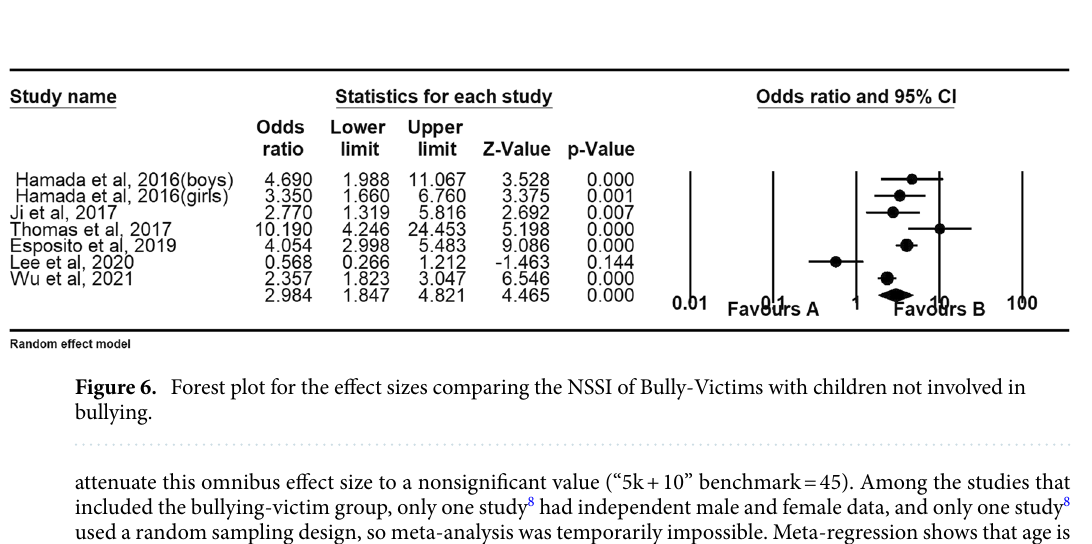
Figure 5. Filled funnel plot of the relationship between non-suicidal self-injury and active bullying.